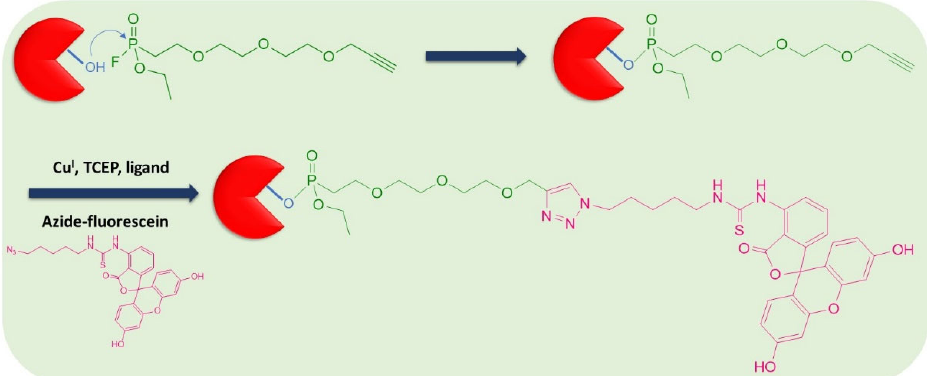
Figure 5. Click chemistry ‐ based labeling of serine hydrolases. The active enzyme is allowed to react with the 1 ‐ alkyne phosphonate derivative. Then, the tag, in this case an azido derivative of fluores ‐ cein, is added to form the final